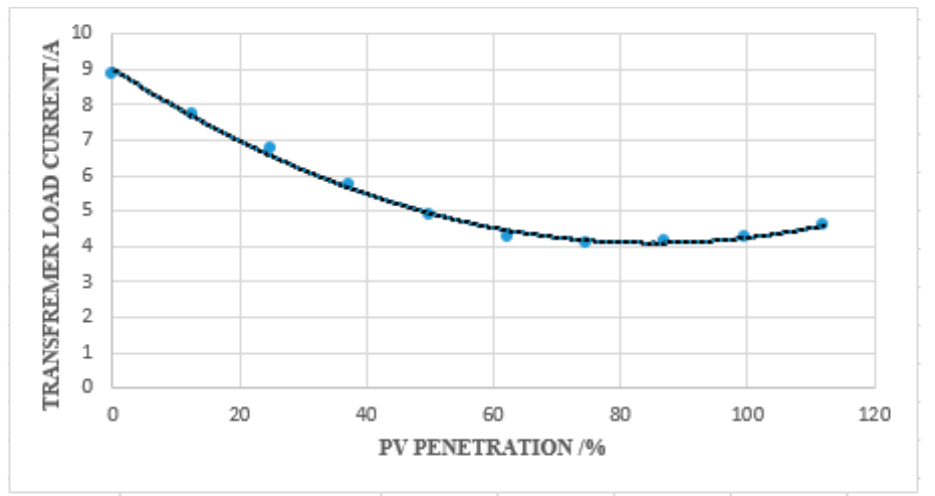
Figure 8. Graphical analysis of transformer load current.